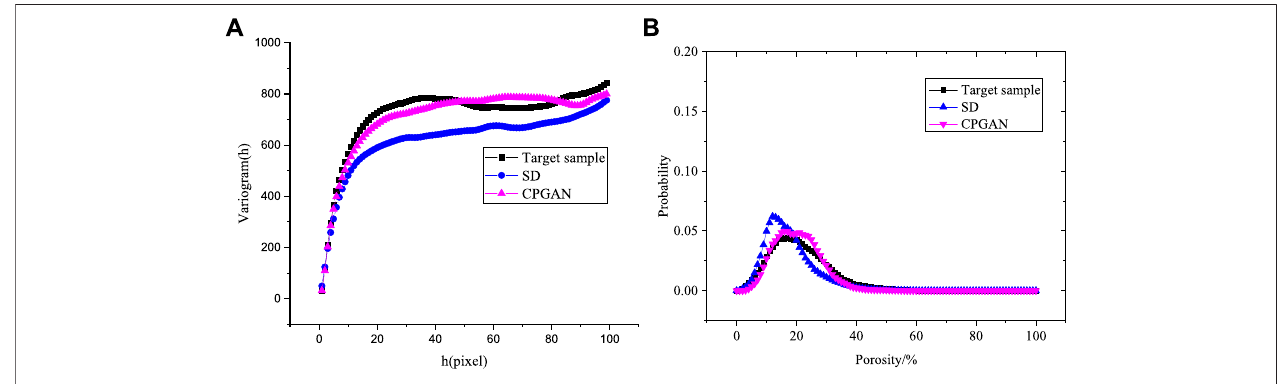
FIGURE 7 | Comparison curve of the variogram (A) and local porosity (B) between target sample and reconstructed structure for different algorithms.